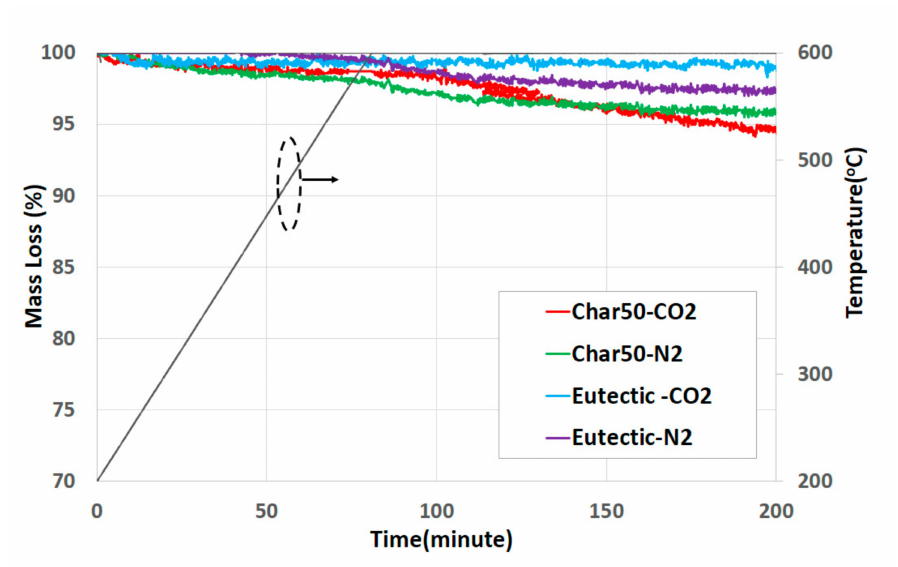
Figure 2. TGA mass changes Char50 decomposition and eutectic stability under N 2 and CO 2 at 600 ◦